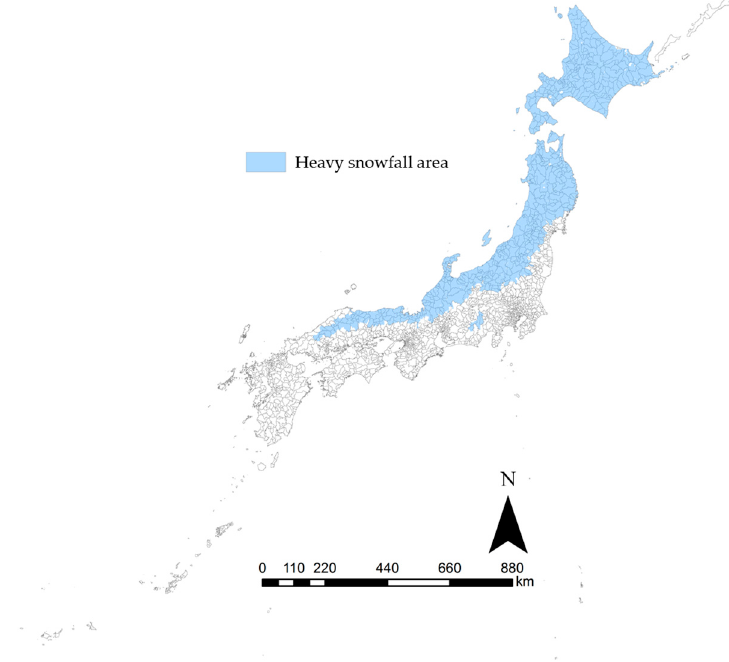
Figure 4. The heavy snowfall areas in Japan.